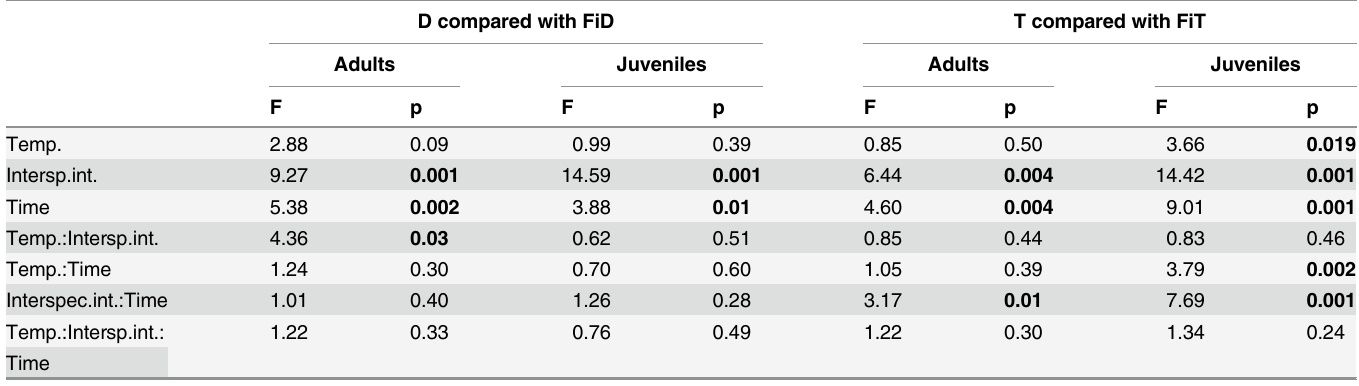
Table 4. Statistical results of the effect of temperature regime on assemblage dynamics. D compared with FiD T compared with FiT Adults Juveniles Adults